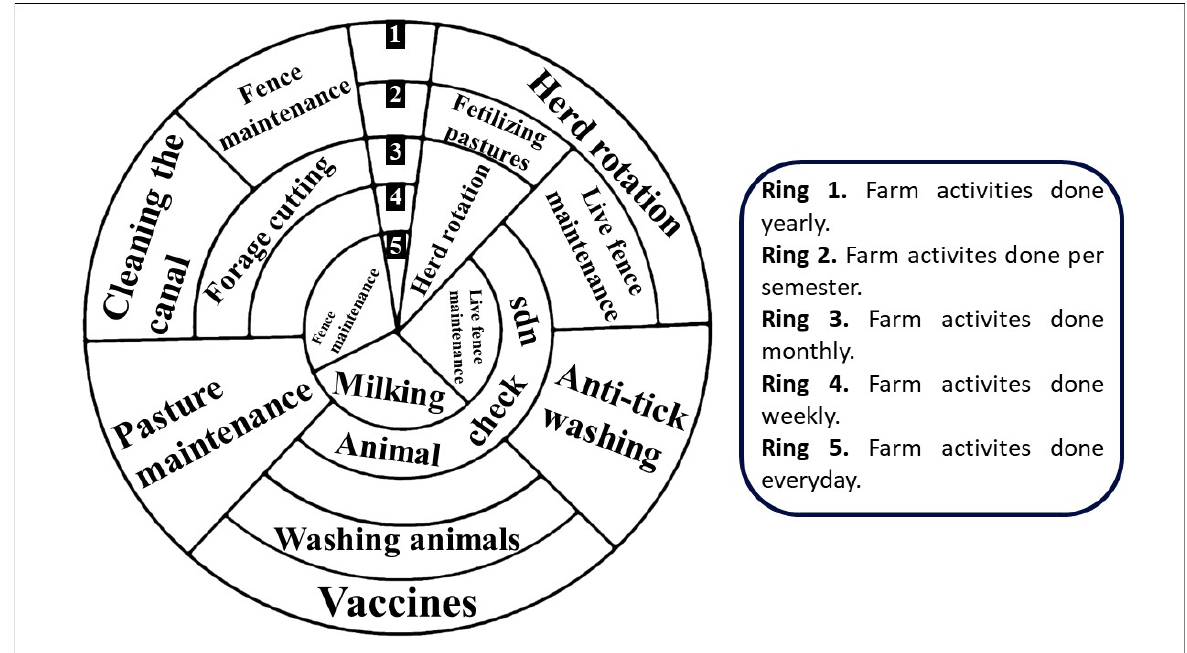
Figure 3. The most important labor activities and frequency of the management and maintenance of silvopastoral systems.